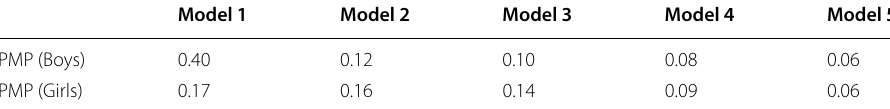
Table 3 Posterior model probabilities for top five models